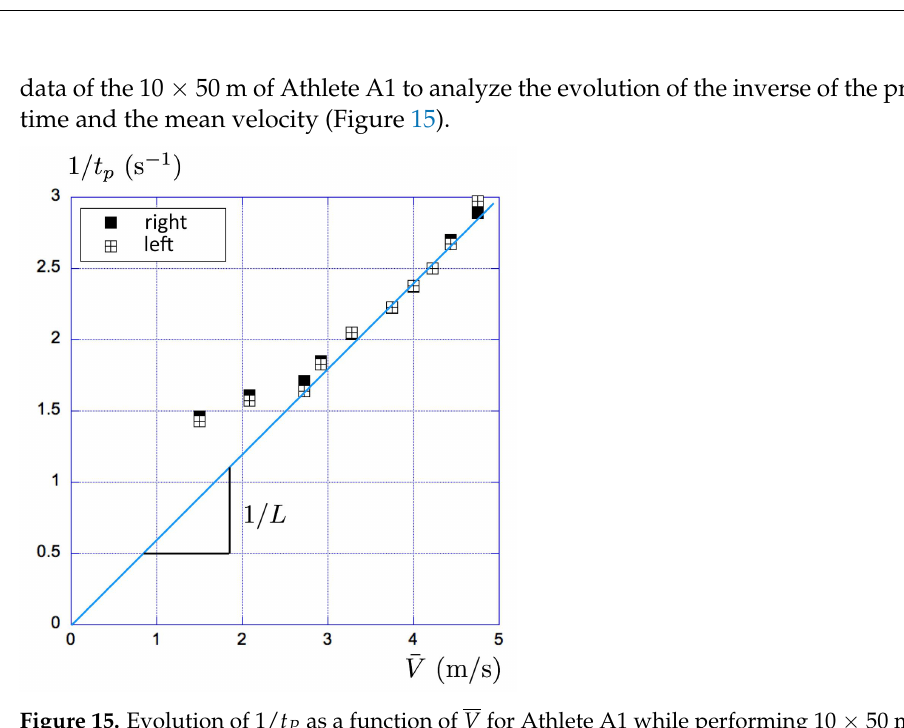
Figure 15. Evolution of 1/ t P as a function of V for Athlete A1 while performing 10 × 50